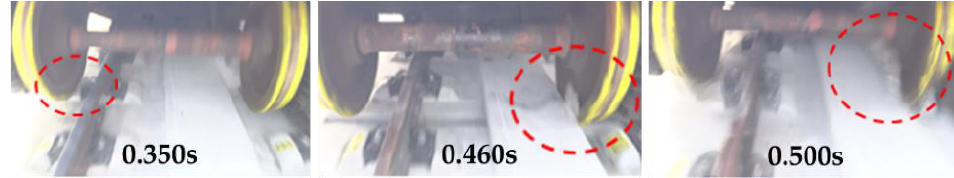
Figure 10. Post-derailment behavior of the flat wagon (1st wheels of front bogie).